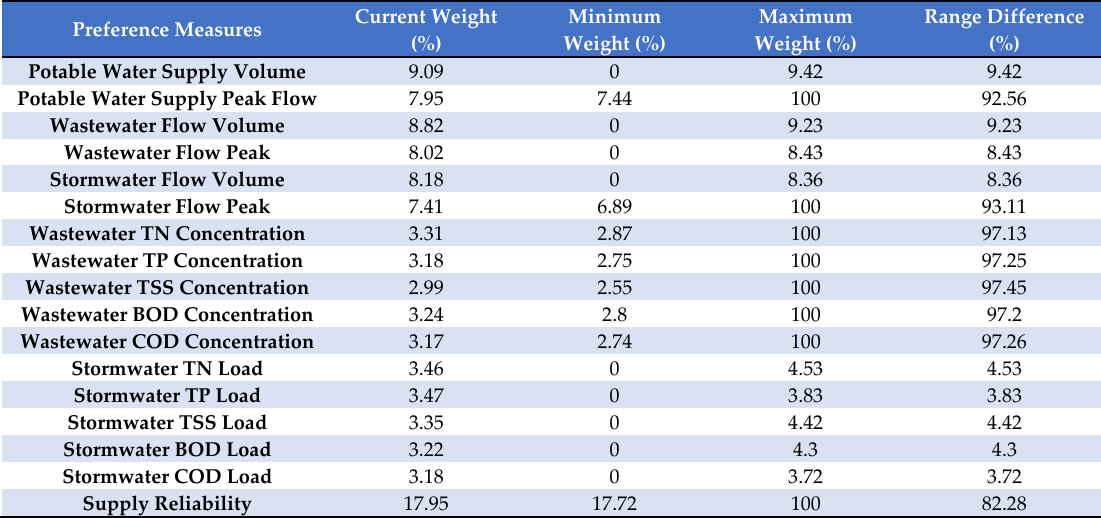
Table 4. Weight sensitivity for the alternatives.